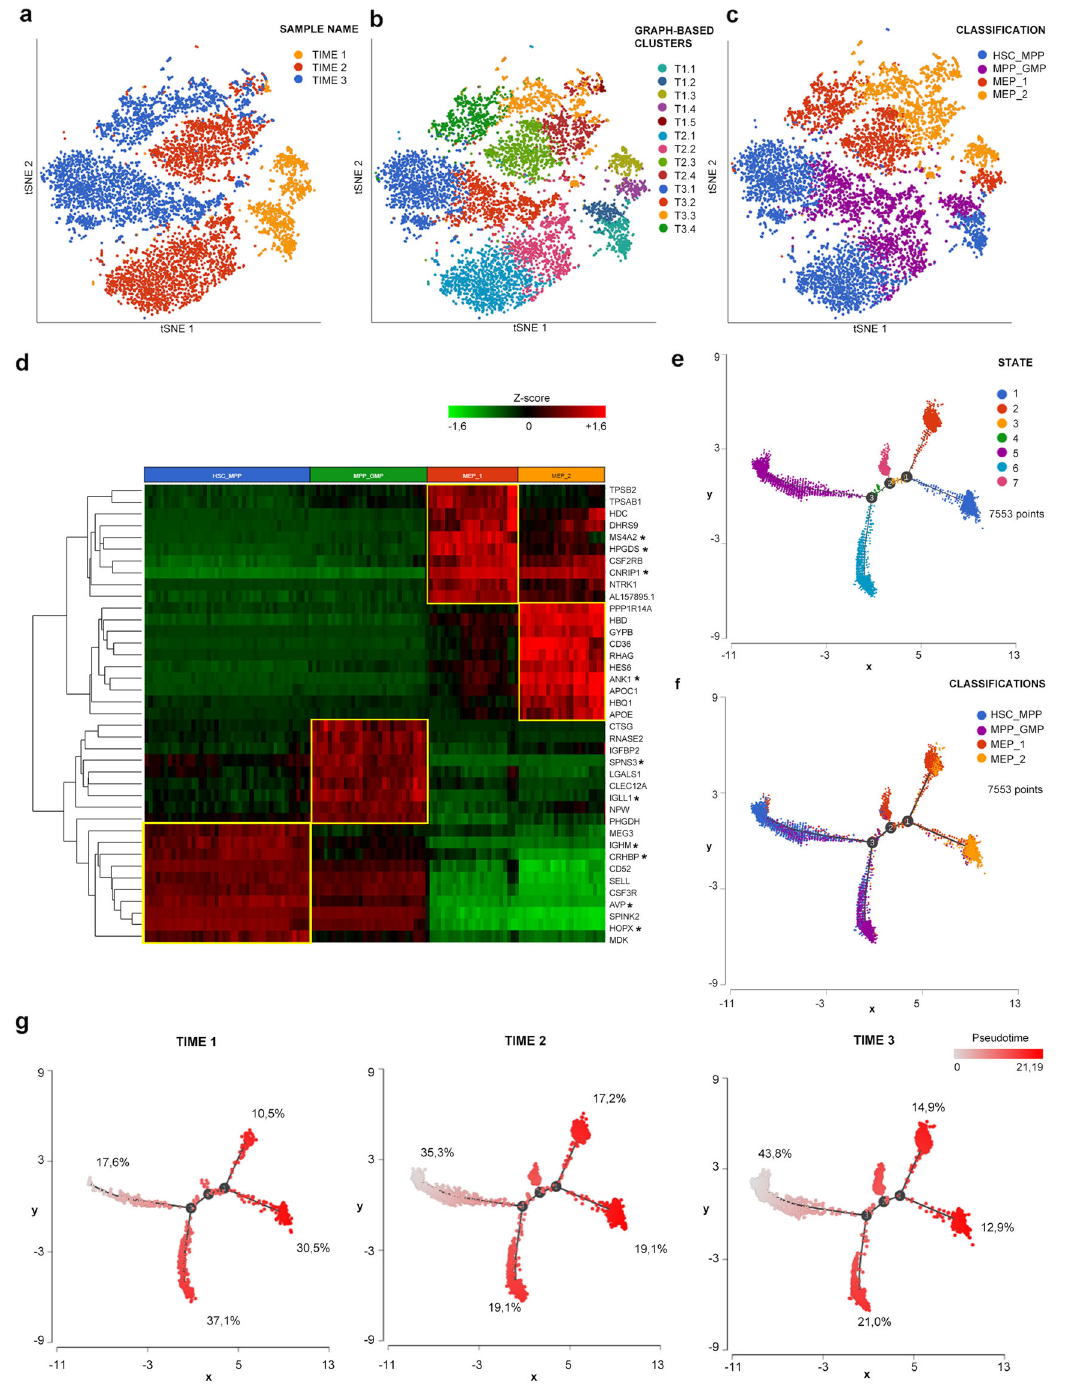
Fig. 3 scRNA-seq clustering and trajectory analysis. a – c tSNE projections of cells from all three samples in which 7553 cells were included. a Cells are distinguished according to the sample of origin. b Different colors indicate clusters identi fi ed by clustering analysis. c The classi fi cation we applied to these clusters. We identi fi ed four cell groups namely HSC_MPP, MPP_GMP, MEP_1, and MEP_2. d The heatmap was generated using the top 10 marker genes for each cell group. Marker genes shared by the three samples are highlighted by the star next to the gene symbol. e The distribution of single cells colored according to the seven states identi fi ed by trajectory analysis. As shown in f , state 5 represented the most primitive one enriched in cells belonging to HSC_MPP cluster. Starting from state 5 the fi rst branch point corresponds to the appearance of a population enriched in MPP_GMP cells. State 7 originates from the second branch point. Two different MEP populations originated from the third branch point, corresponding to MEP_1 and MEP_2 clusters. In g panel trajectories, cells are divided according to the sample of origin. Cells are colored according to pseudotime. Percentages represent the frequency of cells belonging to the indicated sample included in that speci fi c